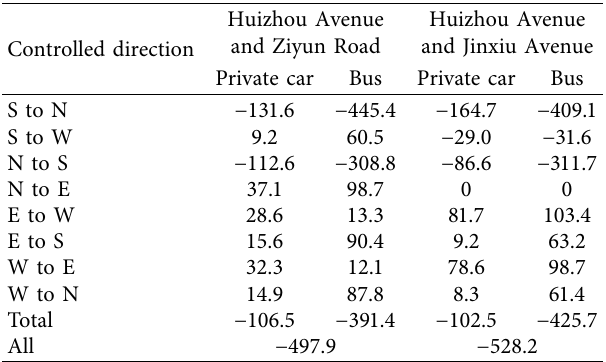
Table 3: Change of the total passenger delay in each direction at the test intersections (s). Controlled